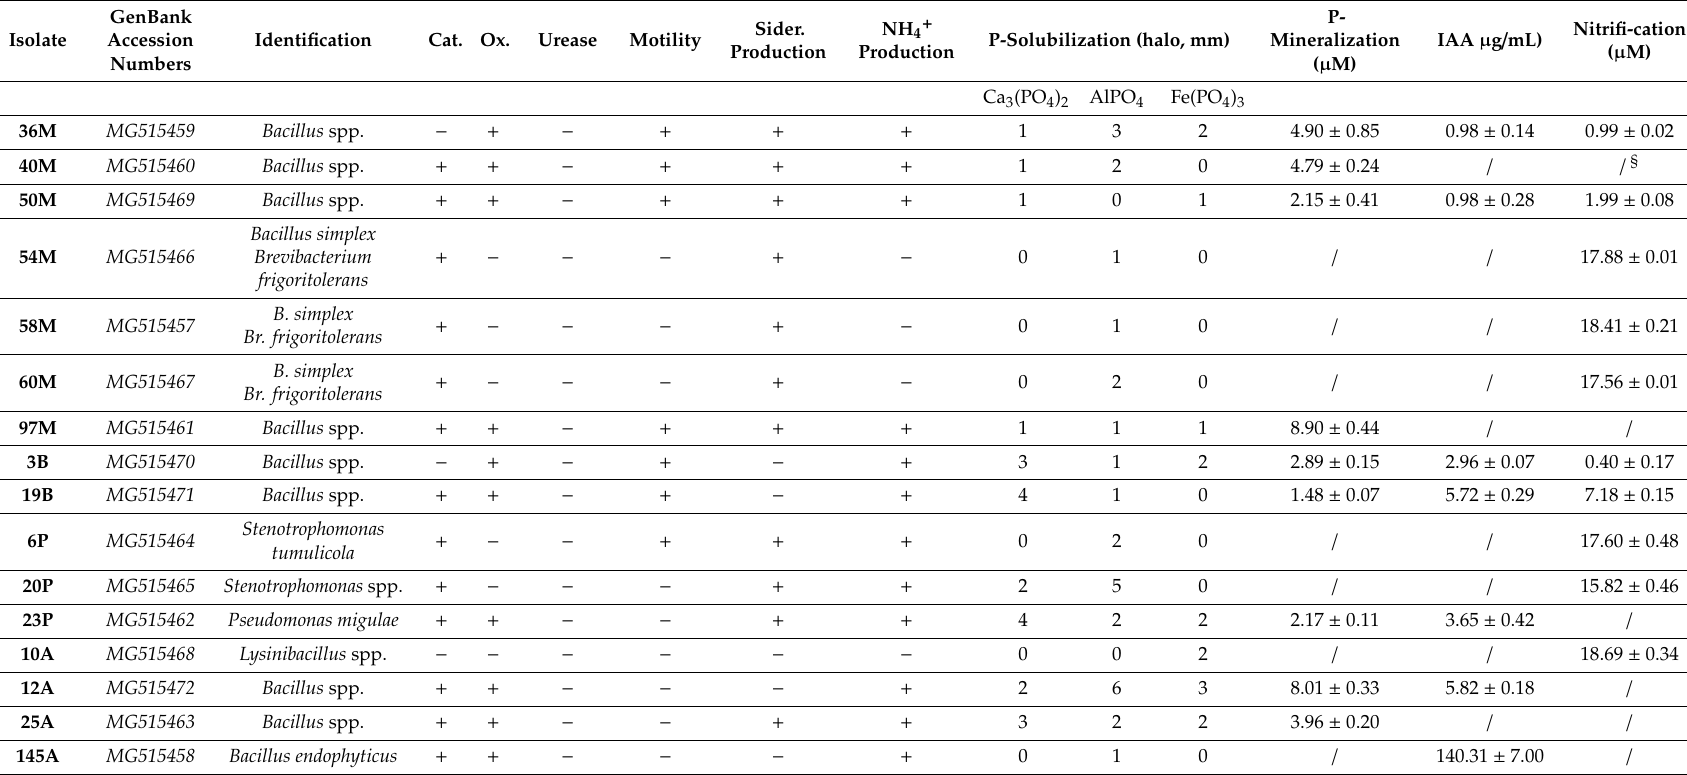
Table 2. Identification and characteristics of the isolates selected after the second step of the research (quantitative assays). Cat., catalase; ox., oxidase; P-solubilization: assays performed in presence of Ca 3 (PO 4 ) 2 , AlPO 4 , and Fe(PO 4 ) 3.